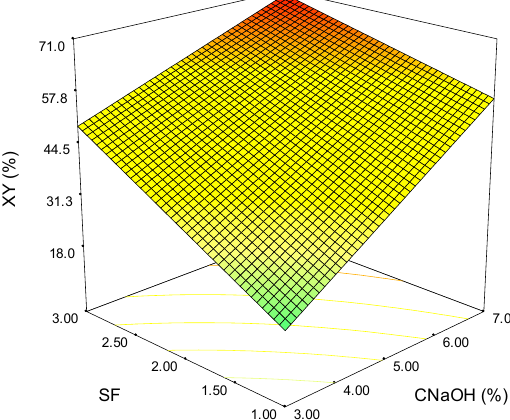
Figure 2. Variation of homoxylan extraction yield as a function of severity factor and alkali concen-